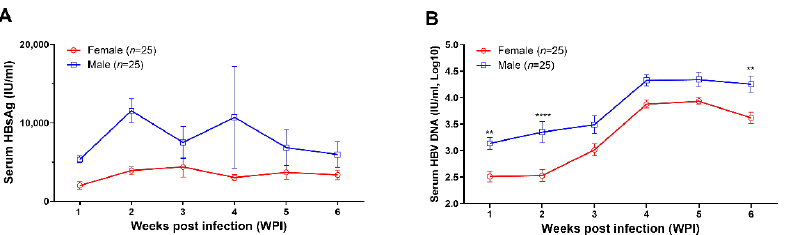
Figure 1. AAV8-1.3HBV established persistent infection in C57BL/6N mice. In addition, 5 × 10 10 GC of AAV-HBV1.3 was given to each mouse via tail vein injection. ( A ) the kinetics of serum HBsAg level (IU/mL) in female ( n = 25) and male mice ( n = 25); ( B ) the kinetics of circulating HBV DNA levels (IU/mL, log10) in female ( n = 25) and male ( n = 25) mice. Data were shown as mean ± SD.